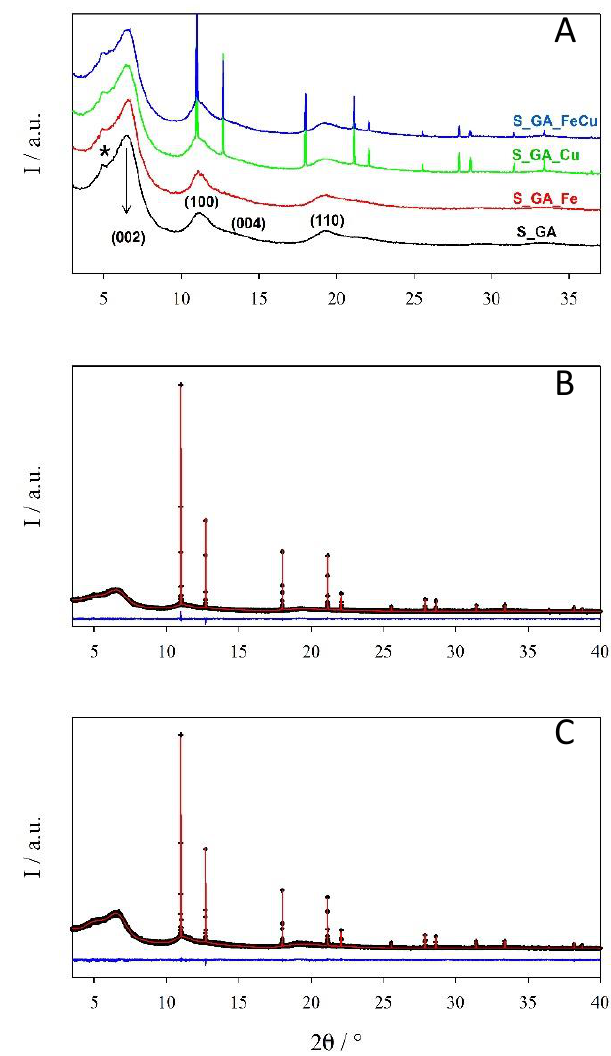
Figure 3. ( A ) XRPD patterns merged using a Δ2θ = 0.050° step size highlighting the graphitic /